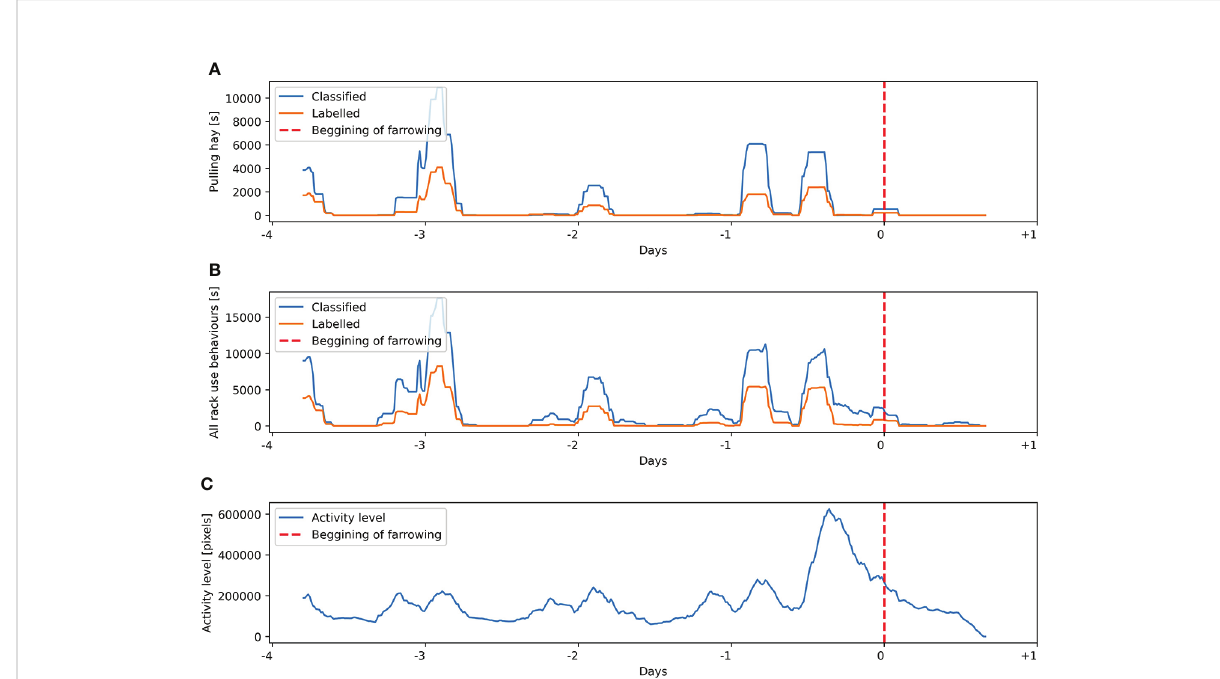
FIGURE 8 Labeling and classi fi cation for sow 5 from the training dataset of (A) pulling hay behavior and (B) all hay rack use behaviors. (C) Activity level estimated on the basis of the Euclidean distance between the centroids of the sow ’ s body in consecutive frames. Presented variables are calculated on a sliding window of 4 h with 15 min